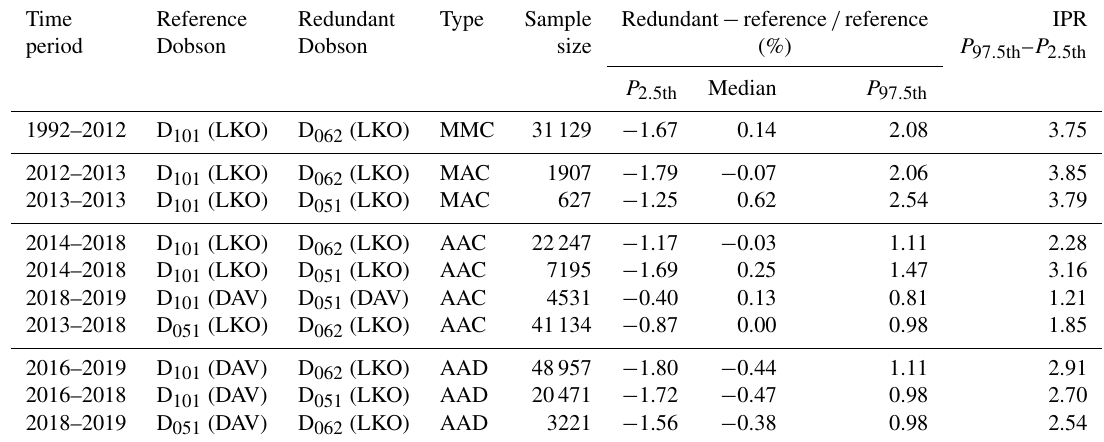
Table 2. Median differences of coincident data averaged over the whole data set for the four subperiods. P 2 . 5th and P 97 . 5th are respectively the 2.5th and 97.5th percentiles of the sample, and IPR is the range between them.